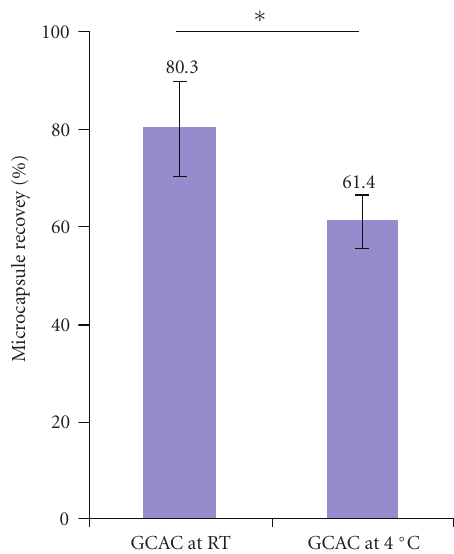
Figure 3: Recovery of microcapsules after 72 hours of the simulated human GI transit. ∗ indicates significant di ff erence at P < . 05 .